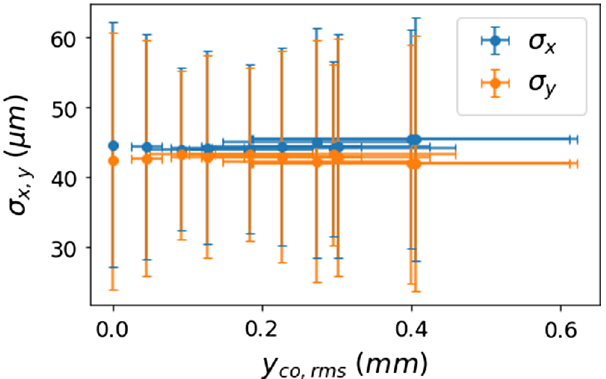
FIG. 11. On-resonance scheme: round beam profile can be maintained with gradually increased closed orbit errors when the machine ’ s tune stays near a difference